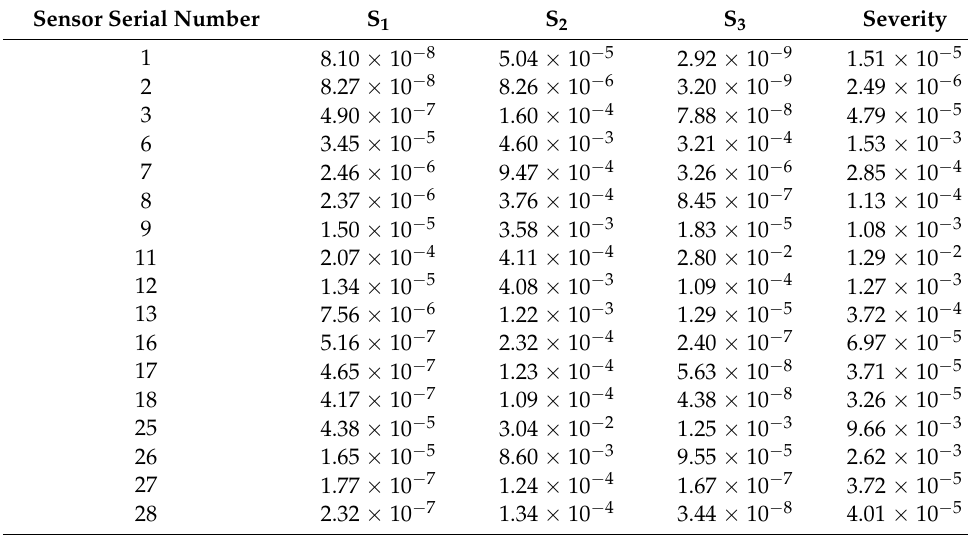
Table 2. The calculation results of severity of t0: